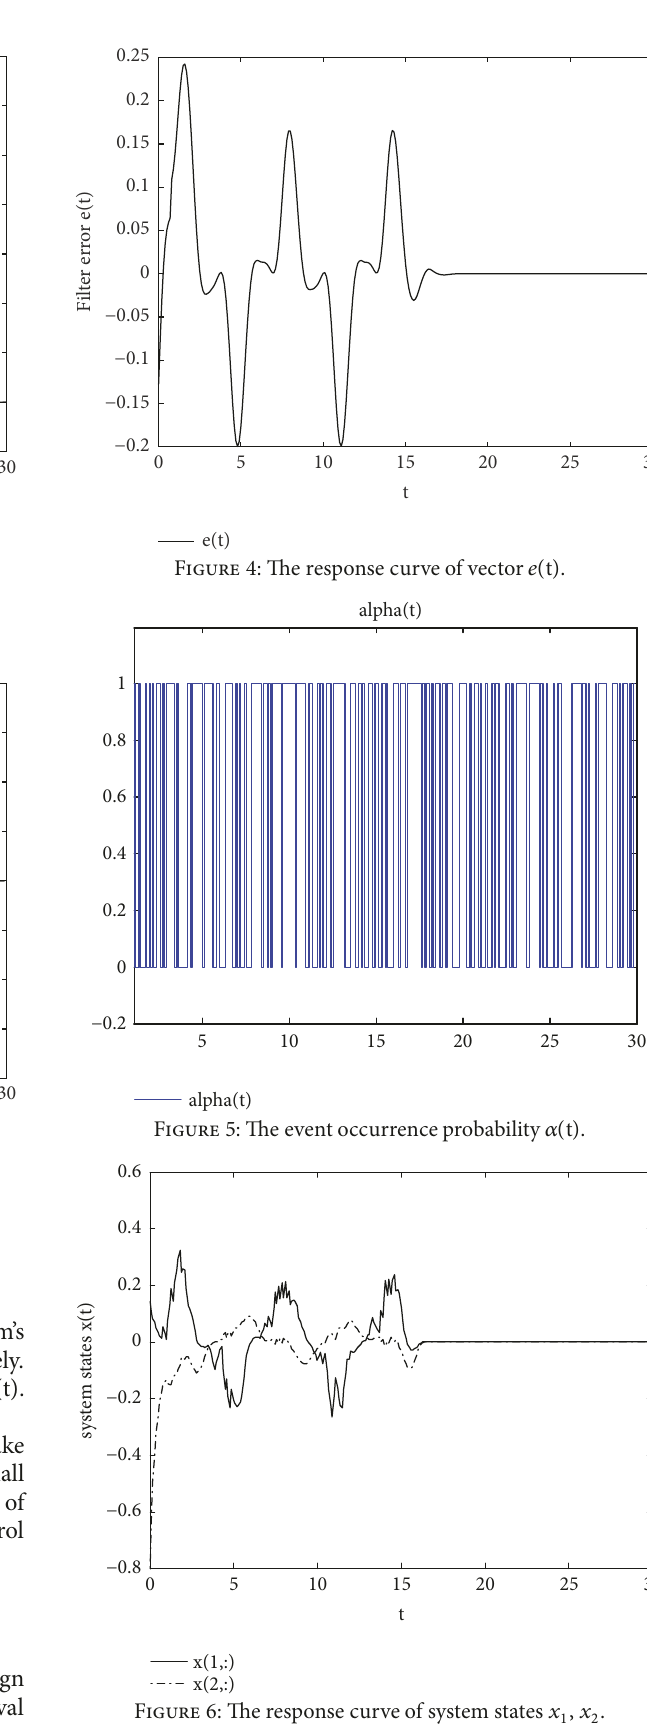
Figure 6: The response curve of system states 𝑥 1 , 𝑥 2